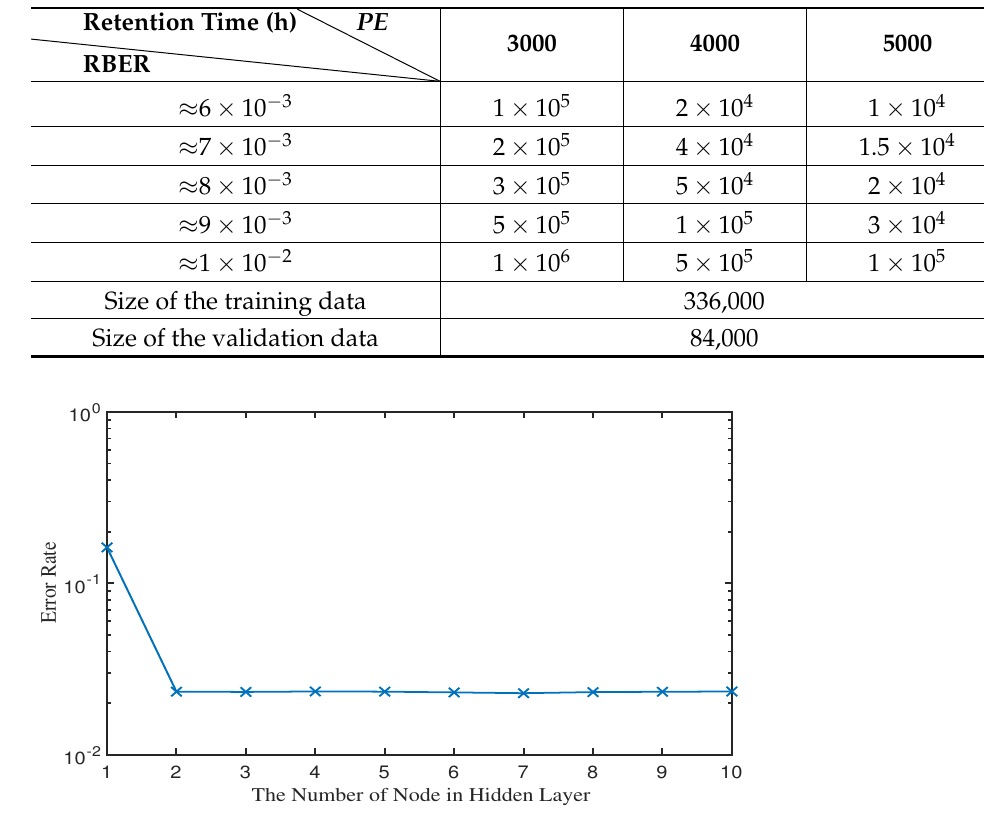
Figure 8. Performance of neural network under the different numbers of hidden layer